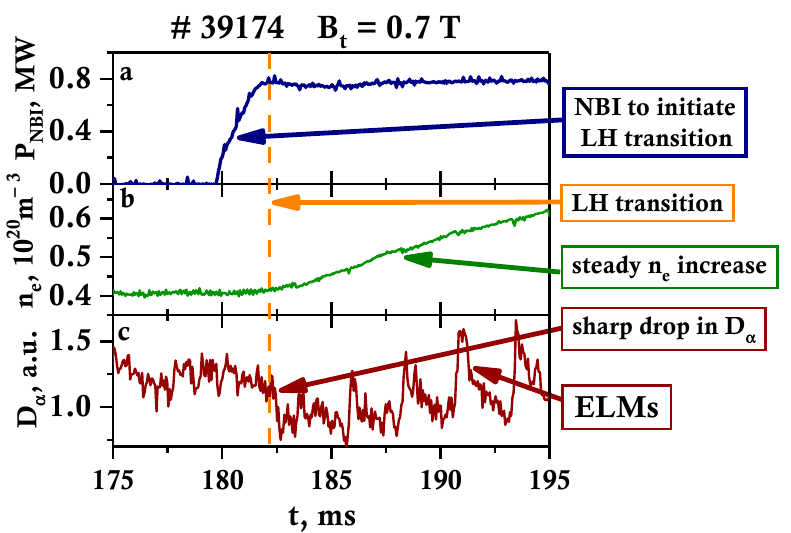
Figure 3. Temporal evolution of plasma parameters on Globus-M2 for discharge #39174: ( a ) NBI power P NBI , ( b ) electron density n e , and ( c ) D α signal.